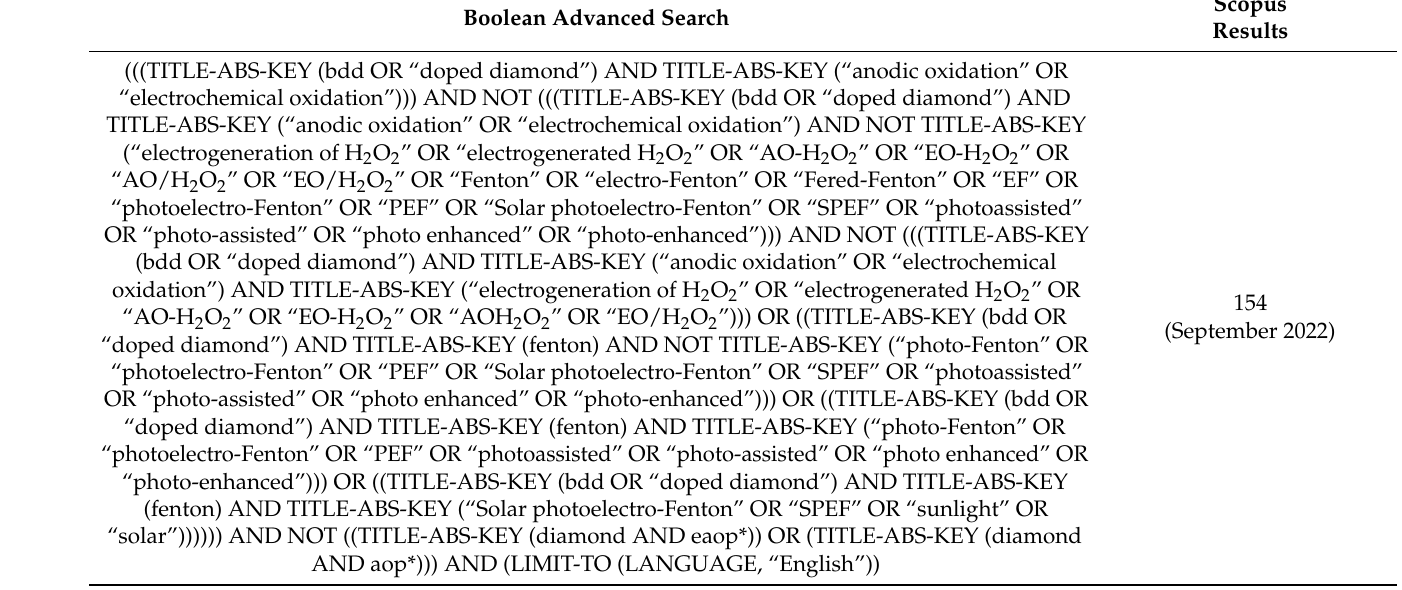
Table 3. Details of the Boolean advanced search query combining both tested sample selection methods (source: the